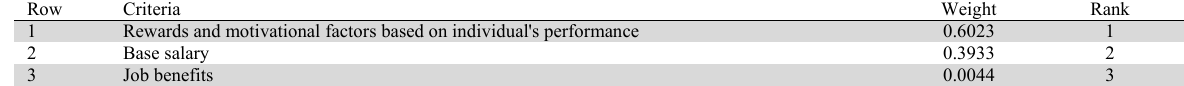
Ranking of compensation system sub-criteria